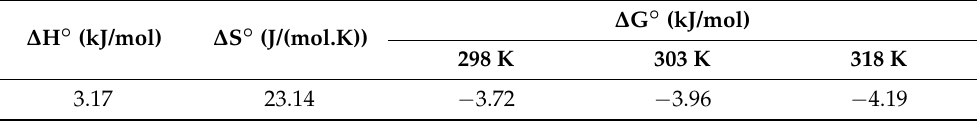
Table 3. Thermodynamic parameters for adsorption of MB on starch cryogel derived from the batch adsorption data.